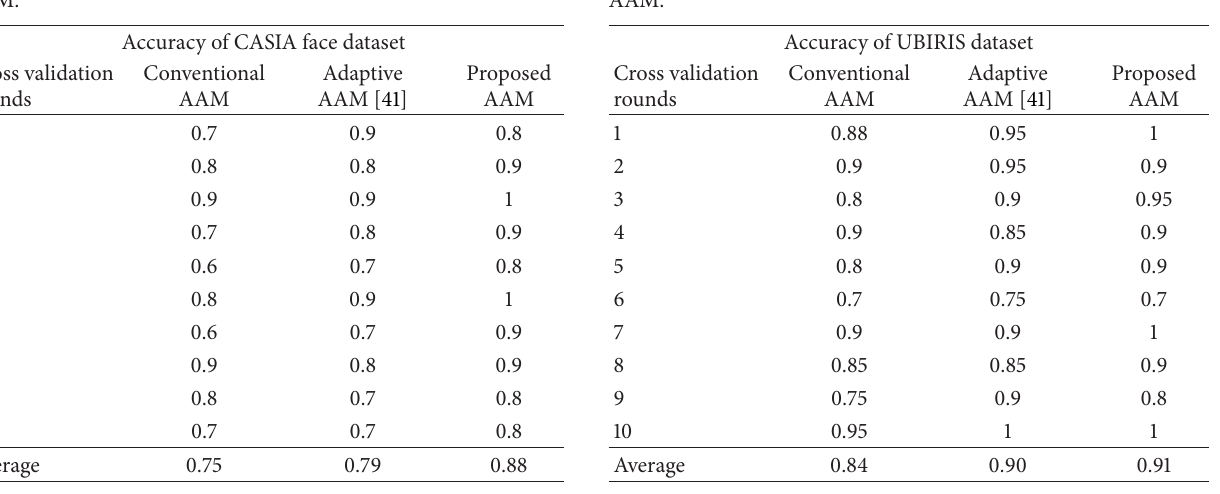
Table 3: Cross validation results for CASIA face dataset in terms of accuracy for conventional AAM, adaptive AAM, and the proposed AAM.